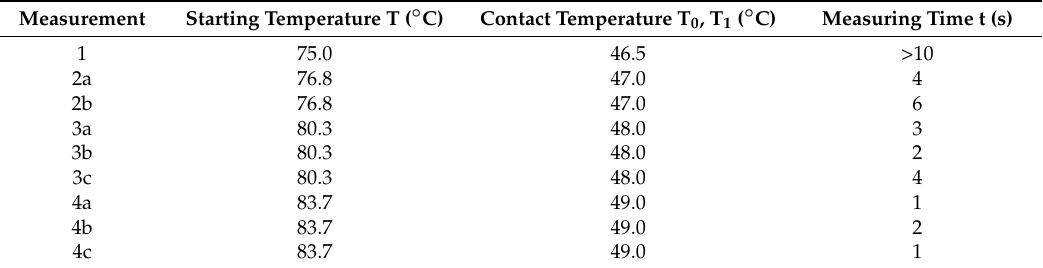
Table 1. Results of orienting measurements.